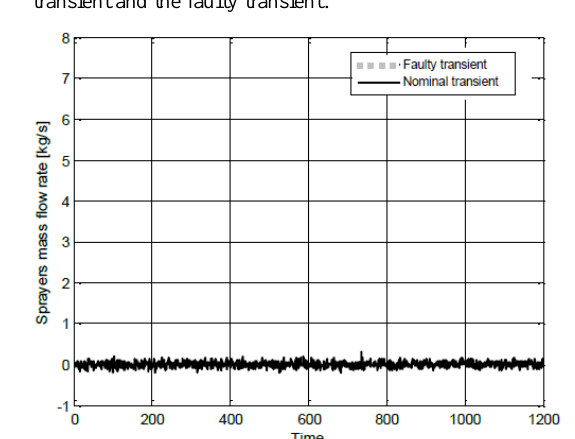
Fig. 13. Evolution of the heaters power for a nominal transient and the faulty transient.